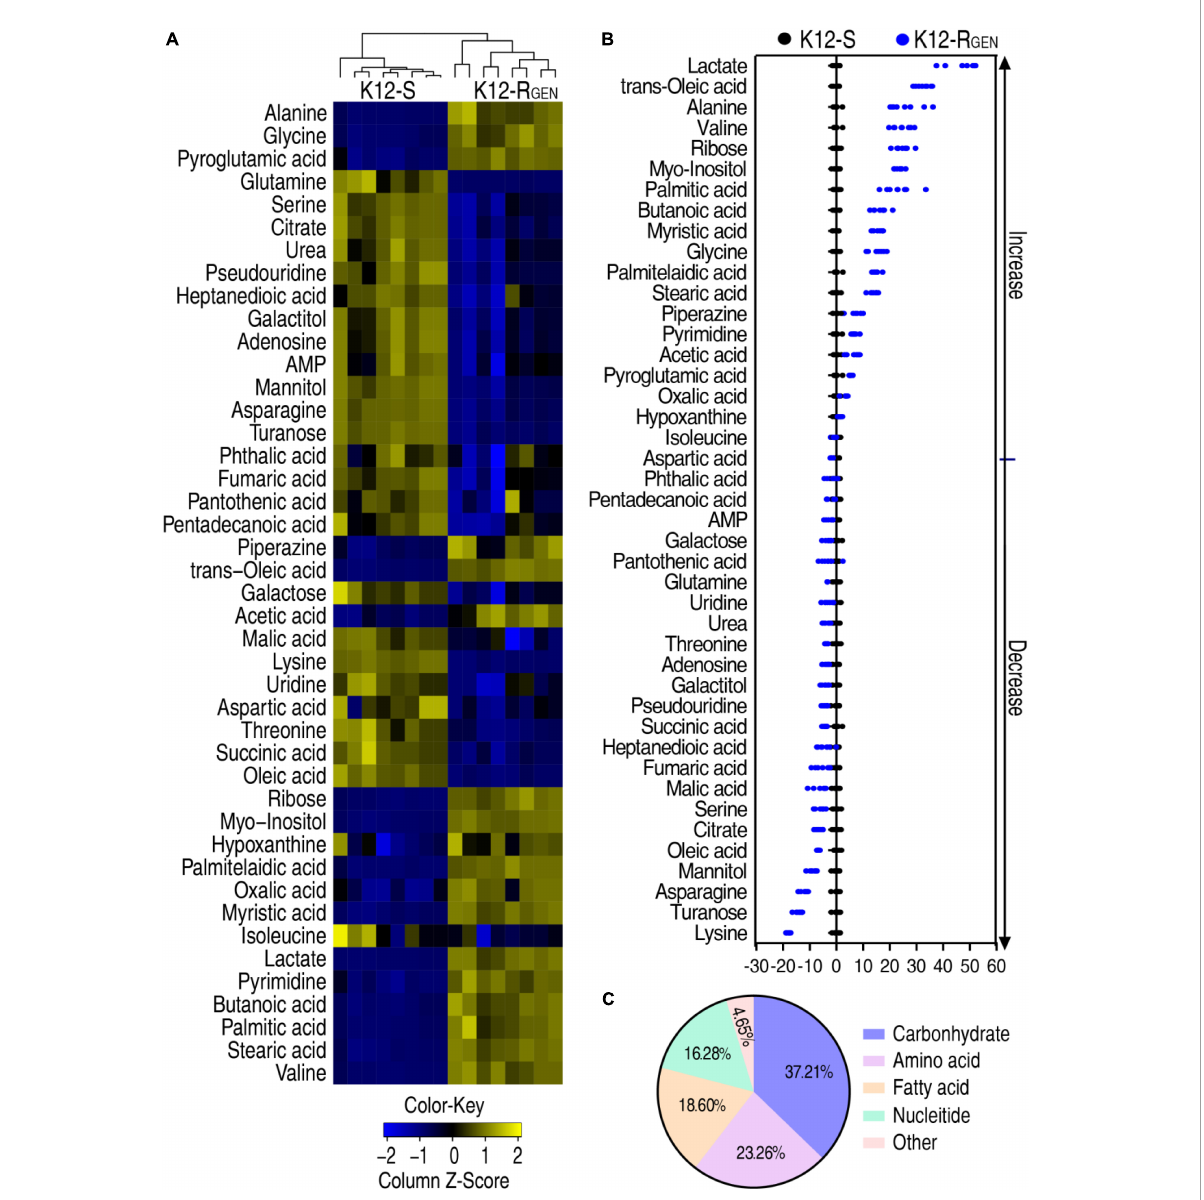
FIGURE3 Differential metabolic profiling between K12-R GEN and K12-S. (A) Heat map showing the differential abundance of metabolites. Yellow and blue indicate an increase and decrease of metabolites relative to the median metabolite level of the control, respectively (see color scale). (B) A Z-score plot of differential metabolites based on control. Each point represents one metabolite in one technical repeat and is colored by sample types. (C) Category of these differential abundances of